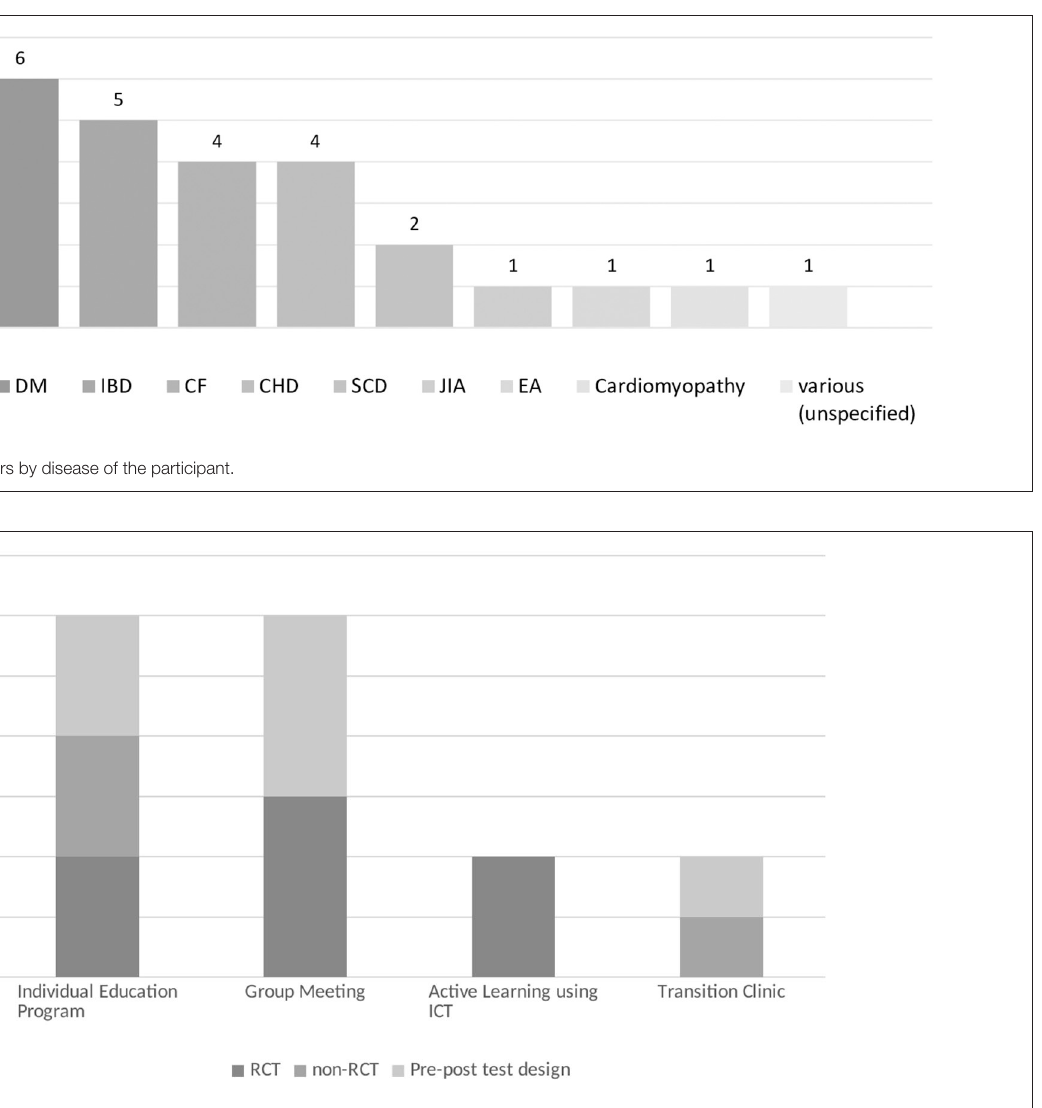
FIGURE 4 | Number of papers by the content of the